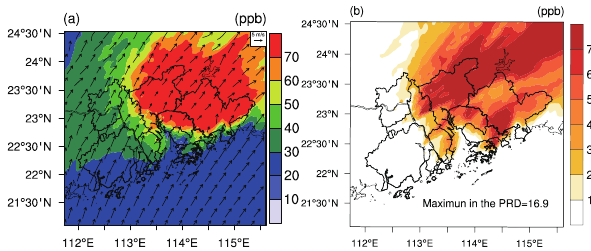
Fig. 11. Spatial distributions of (a) surface ozone and (b) the im- pacts of BVOC emissions on surface ozone at 15:00LT in summer.